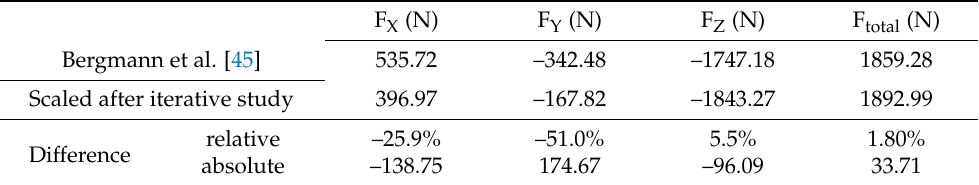
Table 6. Initial maximum hip reaction forces based on Bergmann et al. [45] for walking by an average patient and final values after iterative